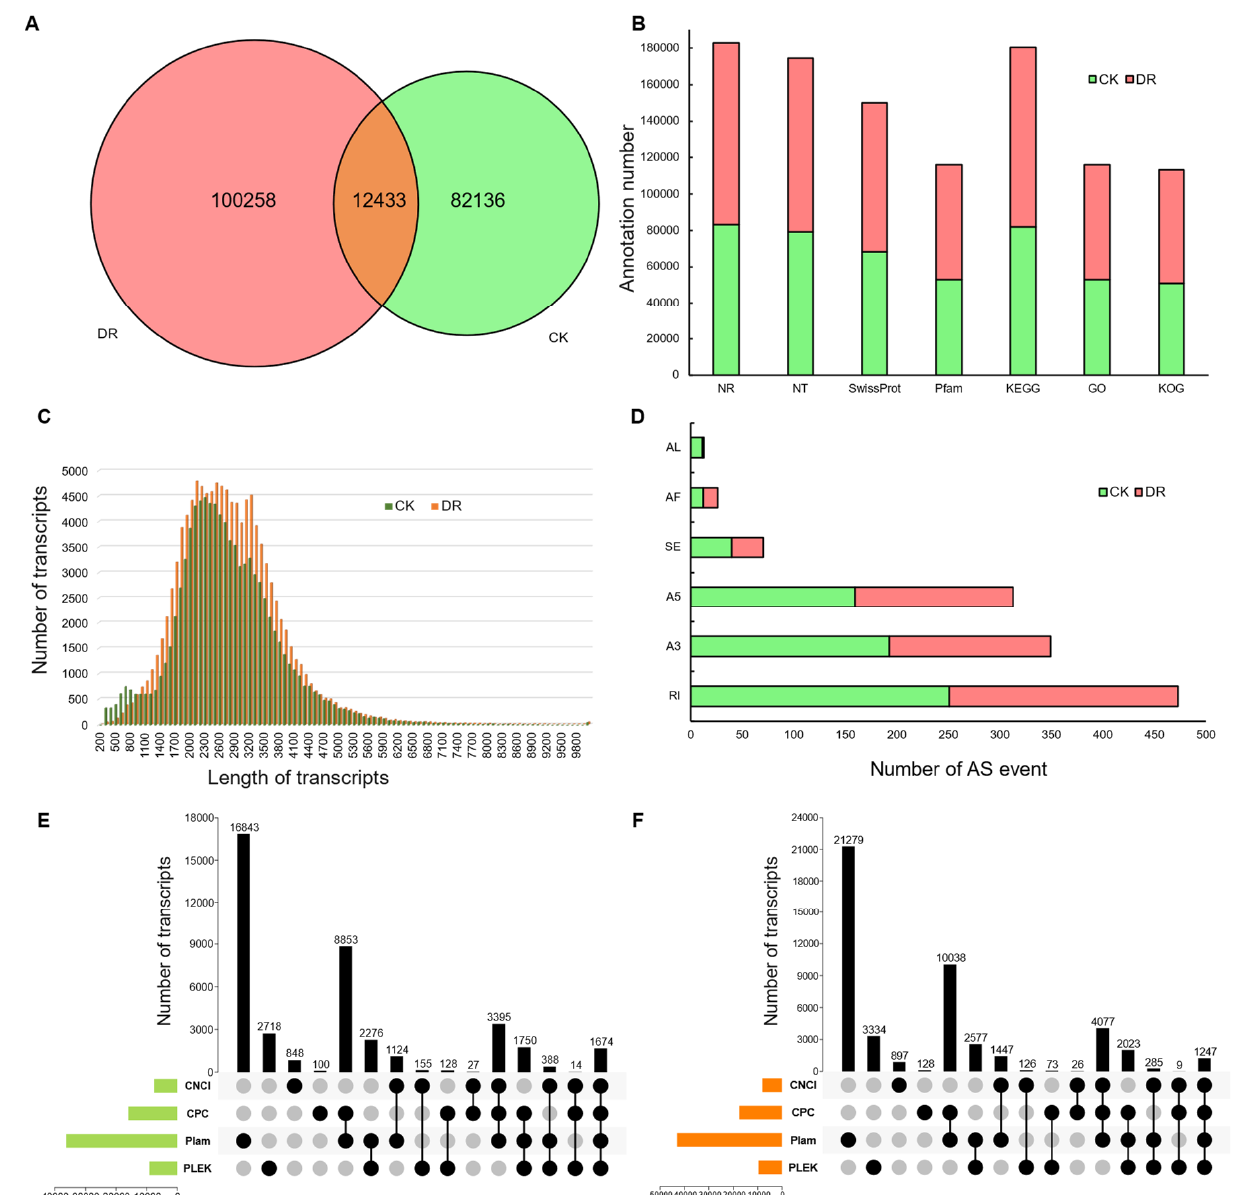
Figure 1 . Gene function annotation and gene structure analysis. ( A ) Venn diagram comparing transcripts between control (CK) and drought (DR) conditions. ( B ) Summary of annotation results across the seven databases. ( C ) Length distribution of transcripts. ( D ) Statistical summary of alternative splicing (AS) events in the two samples. ( E ) UpSet graph showing lncRNA predictions for CK conditions. ( F ) UpSet graph showing lncRNA predictions for DR conditions.